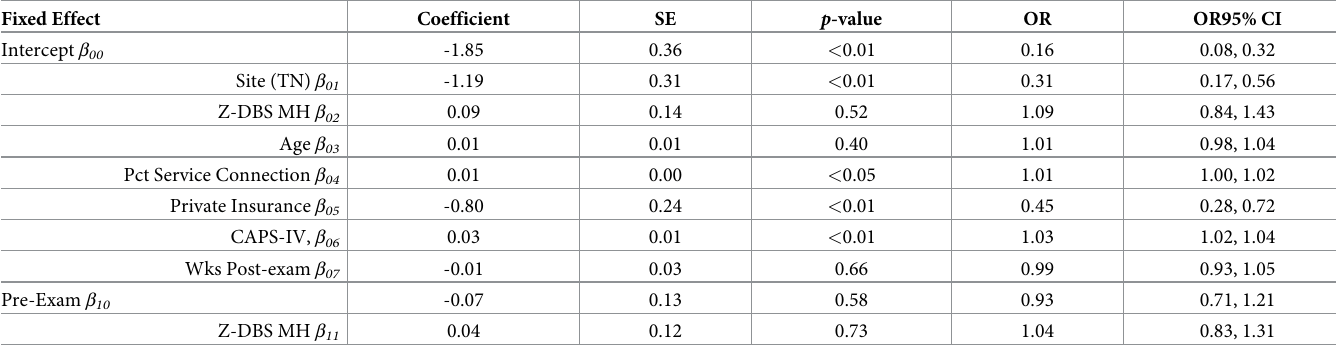
Table 4. Multilevel logistic regression of mental health service